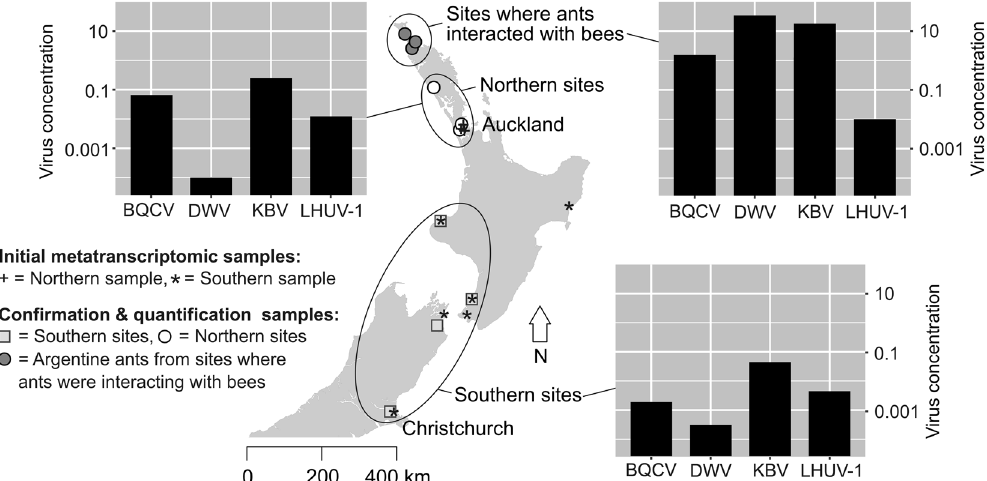
Figure 1. Sampling sites in New Zealand. Both the samples for the initial metatranscriptomic screen (including Sanger sequencing; n = 2) for viruses and the additional samples taken for virus confirmation and quantification (RT-PCR; n = 3) are shown. Samples from the northern-most sites included Argentine ants that were observed raiding honey bee hives, while the other sites were urban and distant from beehives. The concentration of viruses is derived from a standard curve, normalised to the concentration of the internal reference gene Ndufa8 (and due to the normalisation is unit-less). The map was generated in R v 3.1.1 49 with the packages ‘maps’ 50 , ‘mapdata’ 51 ,‘maptools’ 52 and ‘GISTools’ 53 . Full details of sites sampled are presented in Supplementary Table